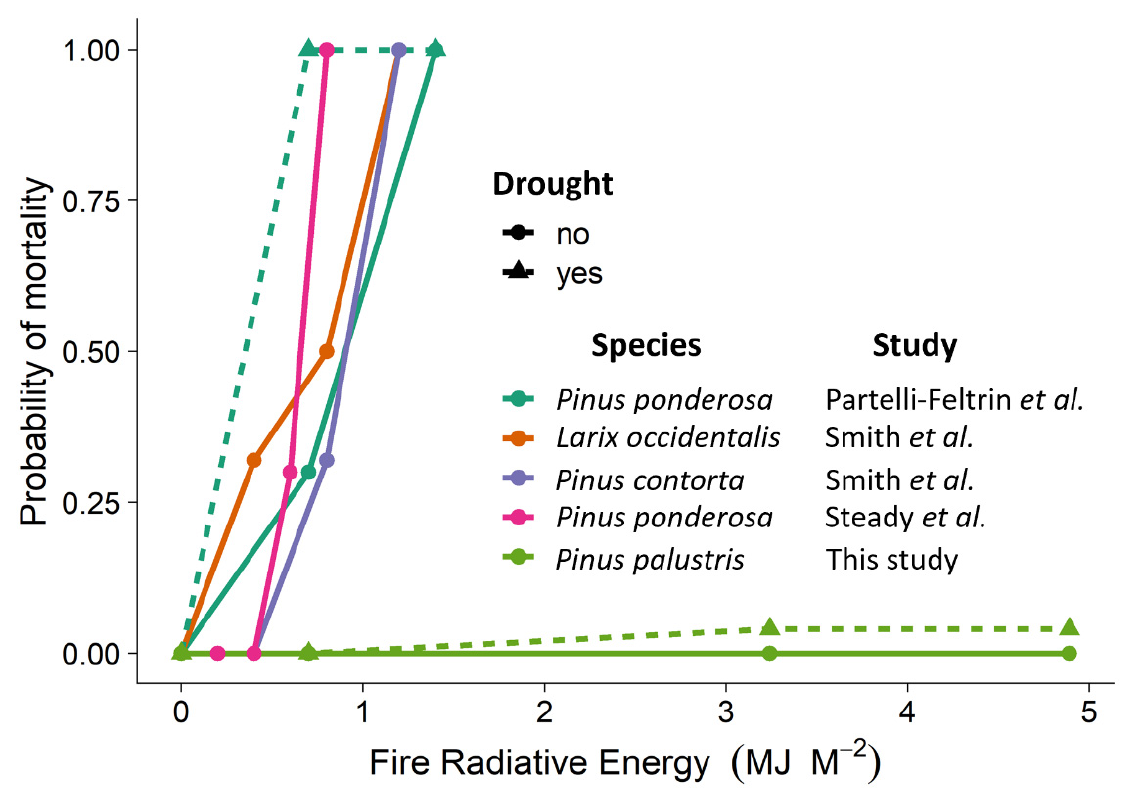
Figure 5. Interaction of fire radiative energy levels (FRE) (MJ m − 2 ) and probability of mortality for this study and others. Well-watered samples are represented by circular symbols and solid lines while droughted samples are represented by triangular symbols and dotted lines. Data from other studies are redrawn from [15,17,21]. Seedlings that resprouted were considered alive for the P. palustris data from this study. Individual points are averaged from all droughted or well-watered samples at a given FRE.